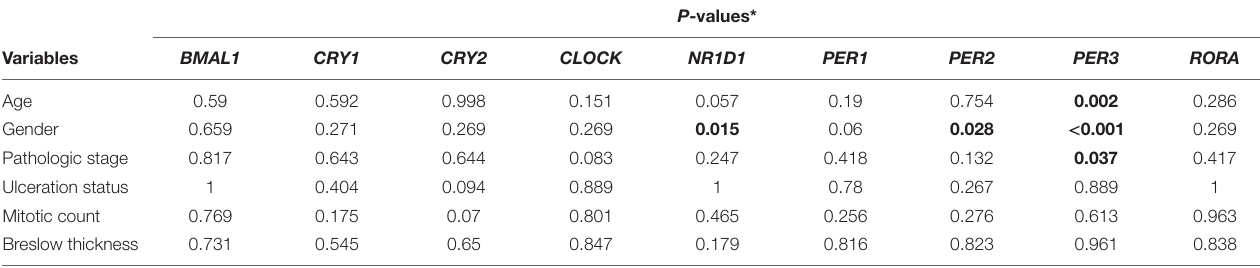
TaBle 1 | Clinicopathological features according to the expression of clock genes in The Cancer Genome Atlas metastatic melanomas.